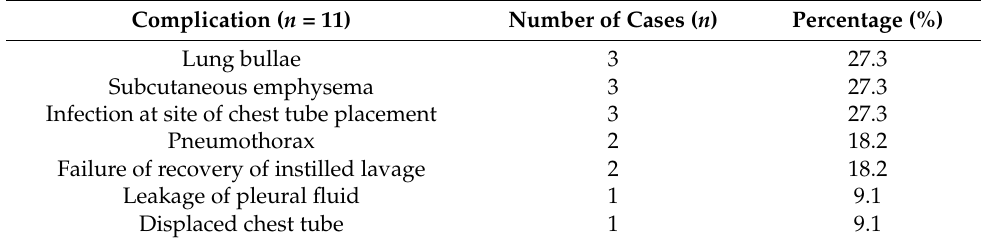
Table 12. Complications of chest tube placement and thoracic